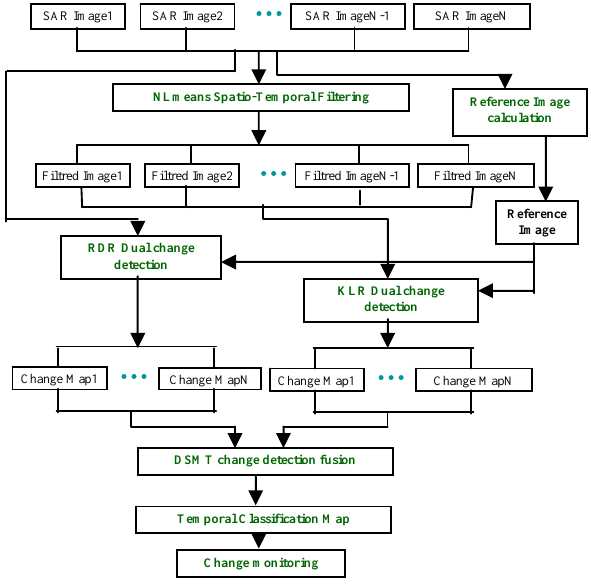
Figure 1. SAR Change detection and monitoring bloc